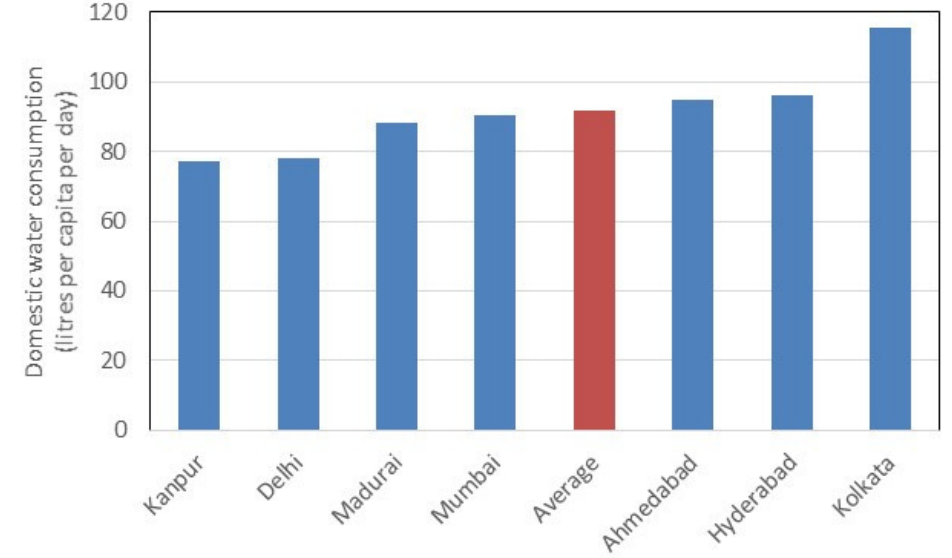
Figure 3. Per capita water consumption by households varies by city. Among the seven Indian cities surveyed, the average consumption was about 92 litres per capita per day.